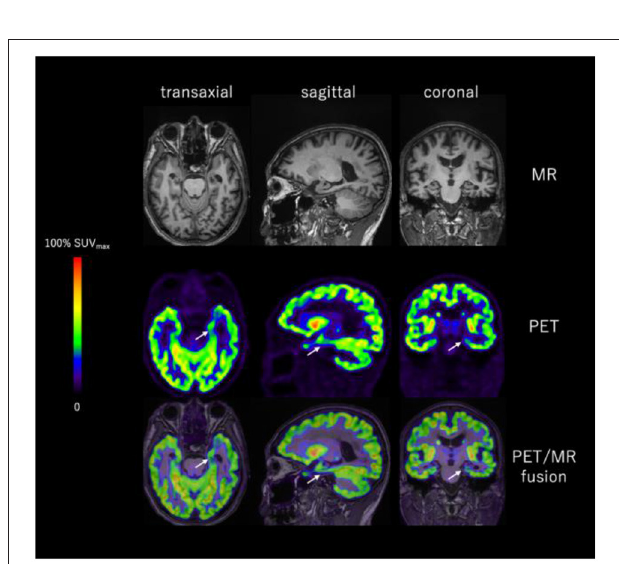
FIGURE 9 | Representative images of T1WI MRI and [ 18 F]SynVesT-1 PET of a [ 18 F]Florbetapir positive AD patient. SV2A binding is significantly reduced in the left hippocampus (white arrow). Images provided by PET Center, Huashan Hospital, Fudan University and Department of Nuclear Medicine, East Hospital, Tongji